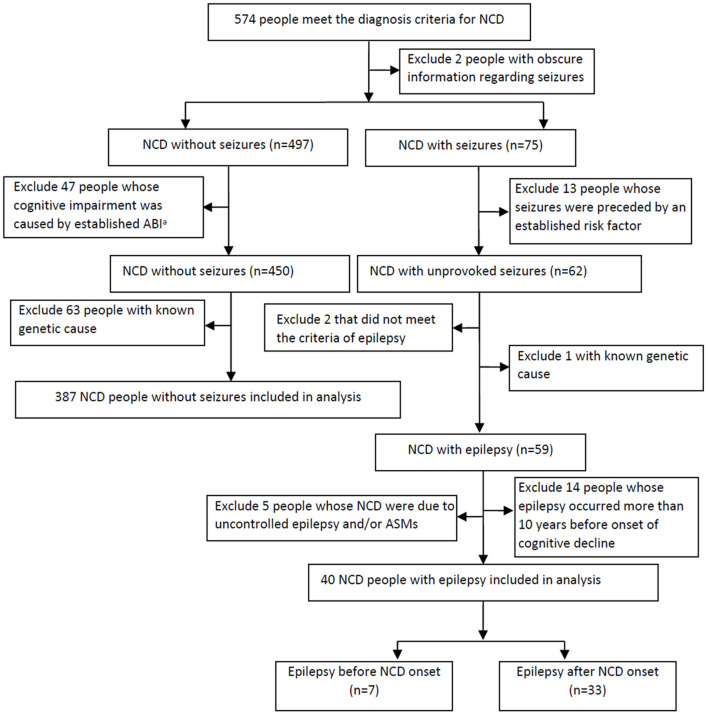
Study flow chart of subject collection. NCD, neurocognitive disorder; ABI, acquired brain injury; ASMs, antiseizure medications.